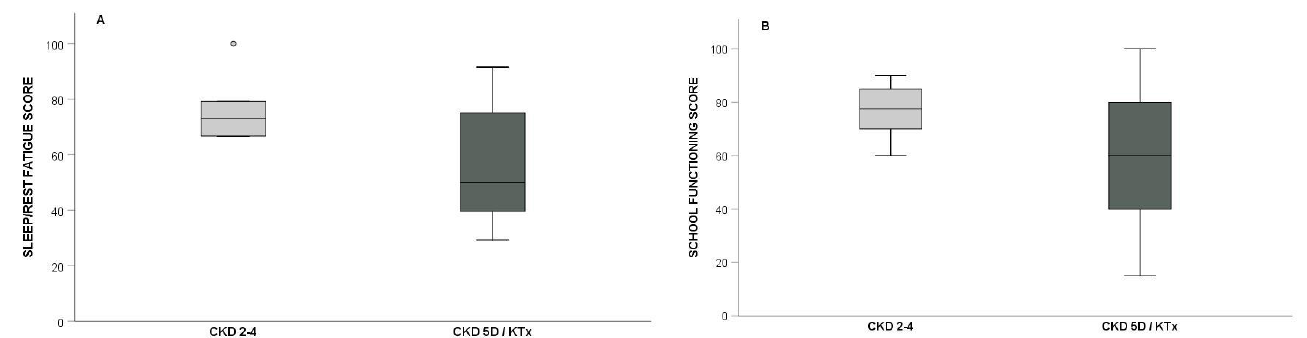
Figure 2. Box plot of ( A ) “Sleep/Rest Fatigue” and ( B ) “School Fucntioning” scores in patients with chronic kidney disease stage 2 – 4 (CKD 2 – 4) compared to patients with chronic kidney disease stage 5 on dialysis (CKD 5D) or kidney transplantation (KTx).